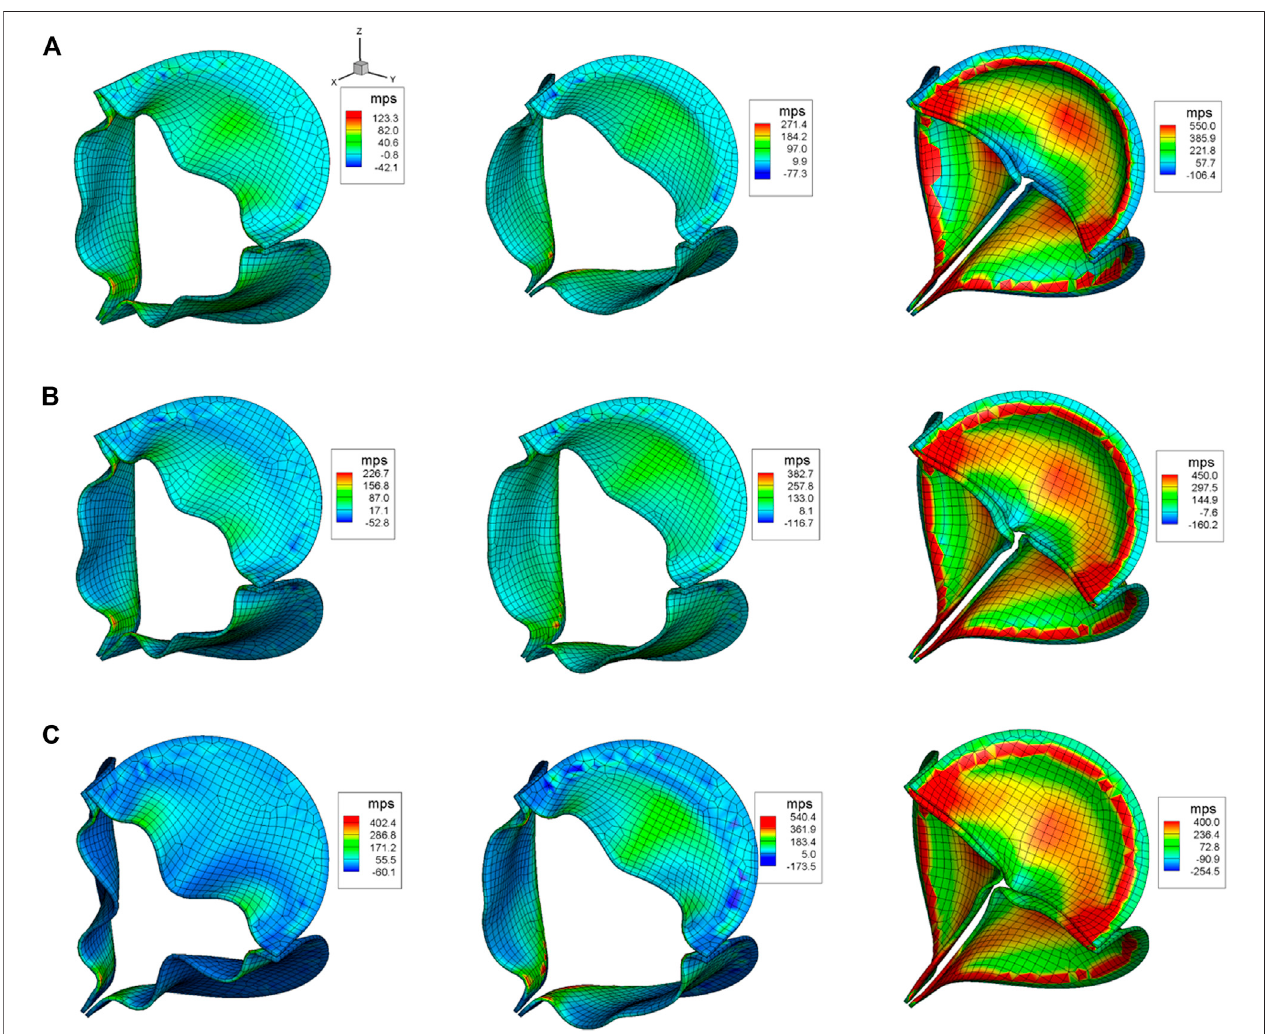
FIGURE7| Aorticlea fl etstresses for (A) E =375 kPa; (B) E =750 kPa;and (C) E =1500 kPaduringtheopeningandclosing phasesatt=4.4,22.0,and34.8 cs.